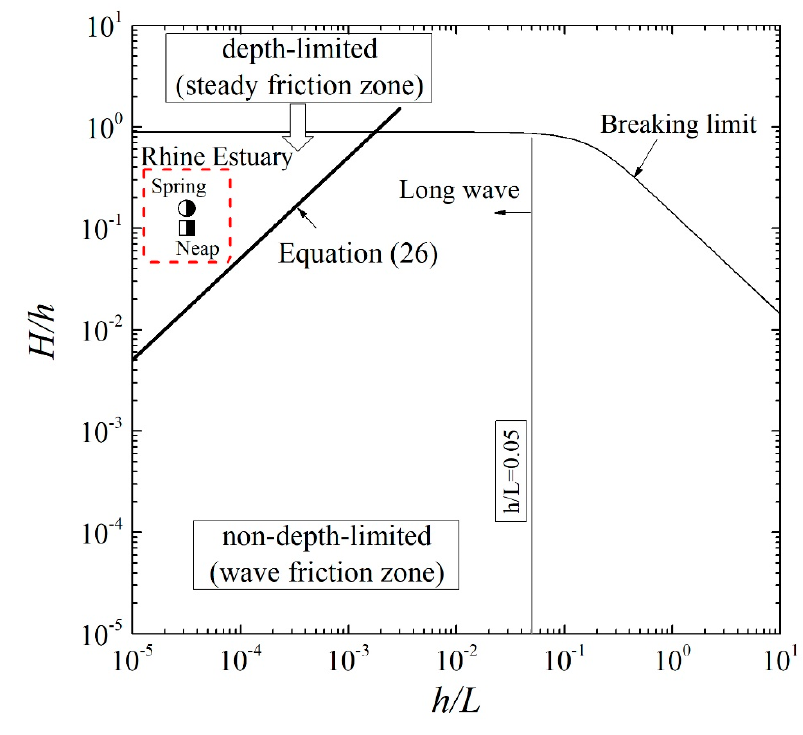
Figure 9. Demarcation line in terms of H / h and h / L